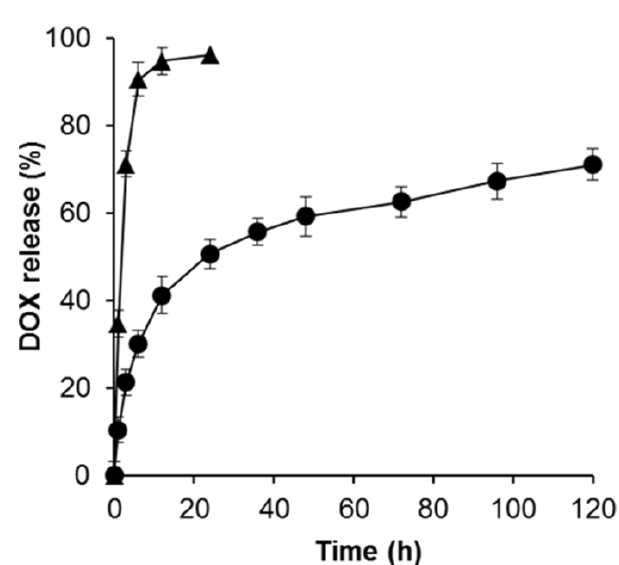
Figure 6. Cumulative release profile of DOX from SPION@HP ( ● ) at predetermined time intervals. Each marked point corresponds to 0, 1, 3, 6, 12, 24, 36, 48, 72, 96, and 120 h. The release of free DOX ( ▲ ) was carried out as a control, in which the amount of free DOX was equivalent to the amount of loaded DOX in the SPION@HP. All experiments were performed three times in PBS (0.01 M) at 37 °C.